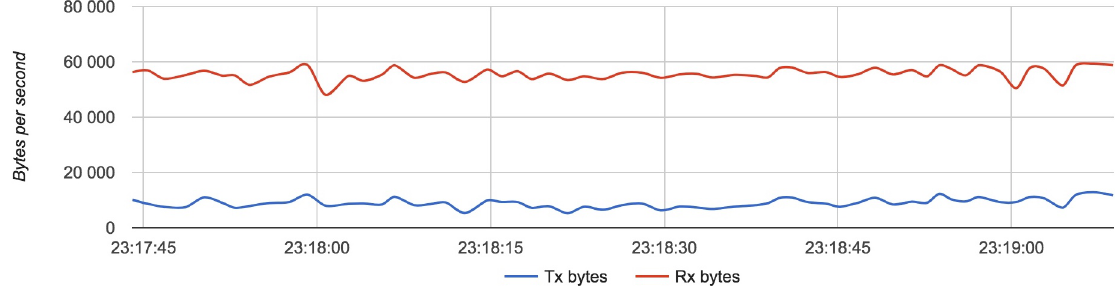
Figure 22. Bandwidth usage for a server with Configuration 3.